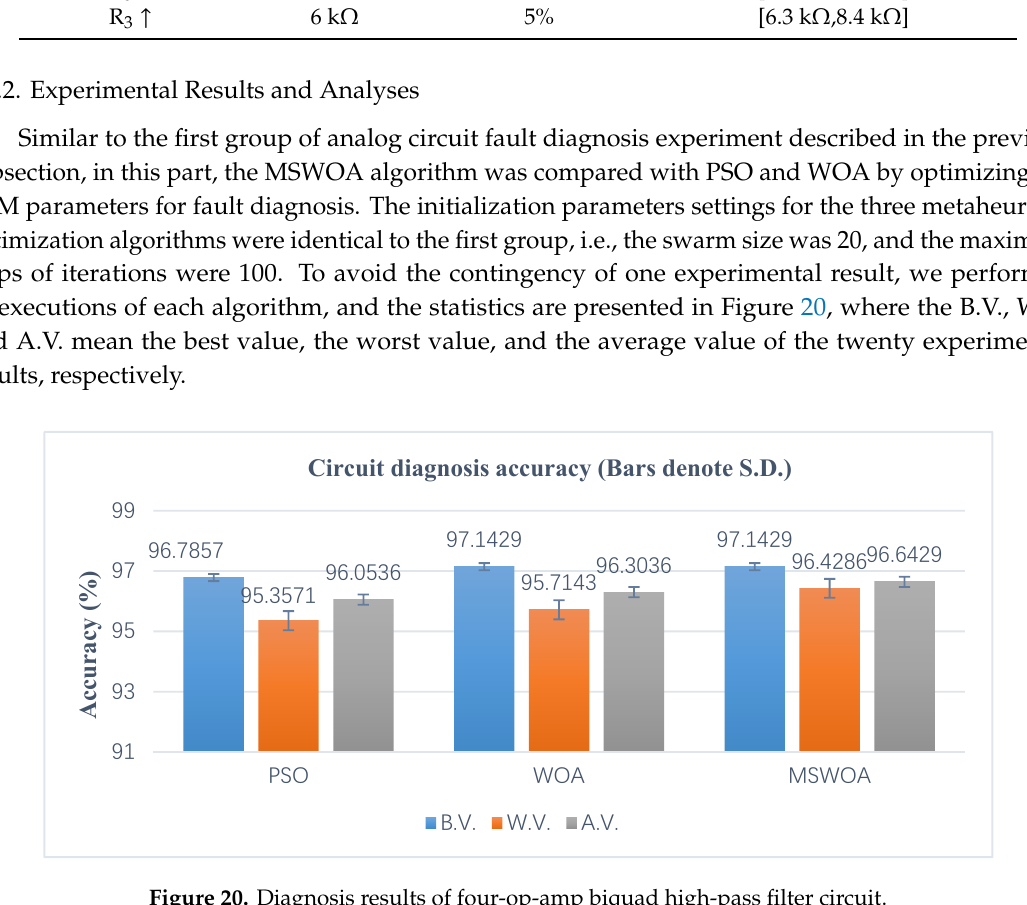
Figure 20. Diagnosis results of four-op-amp biquad high-pass filter circuit.